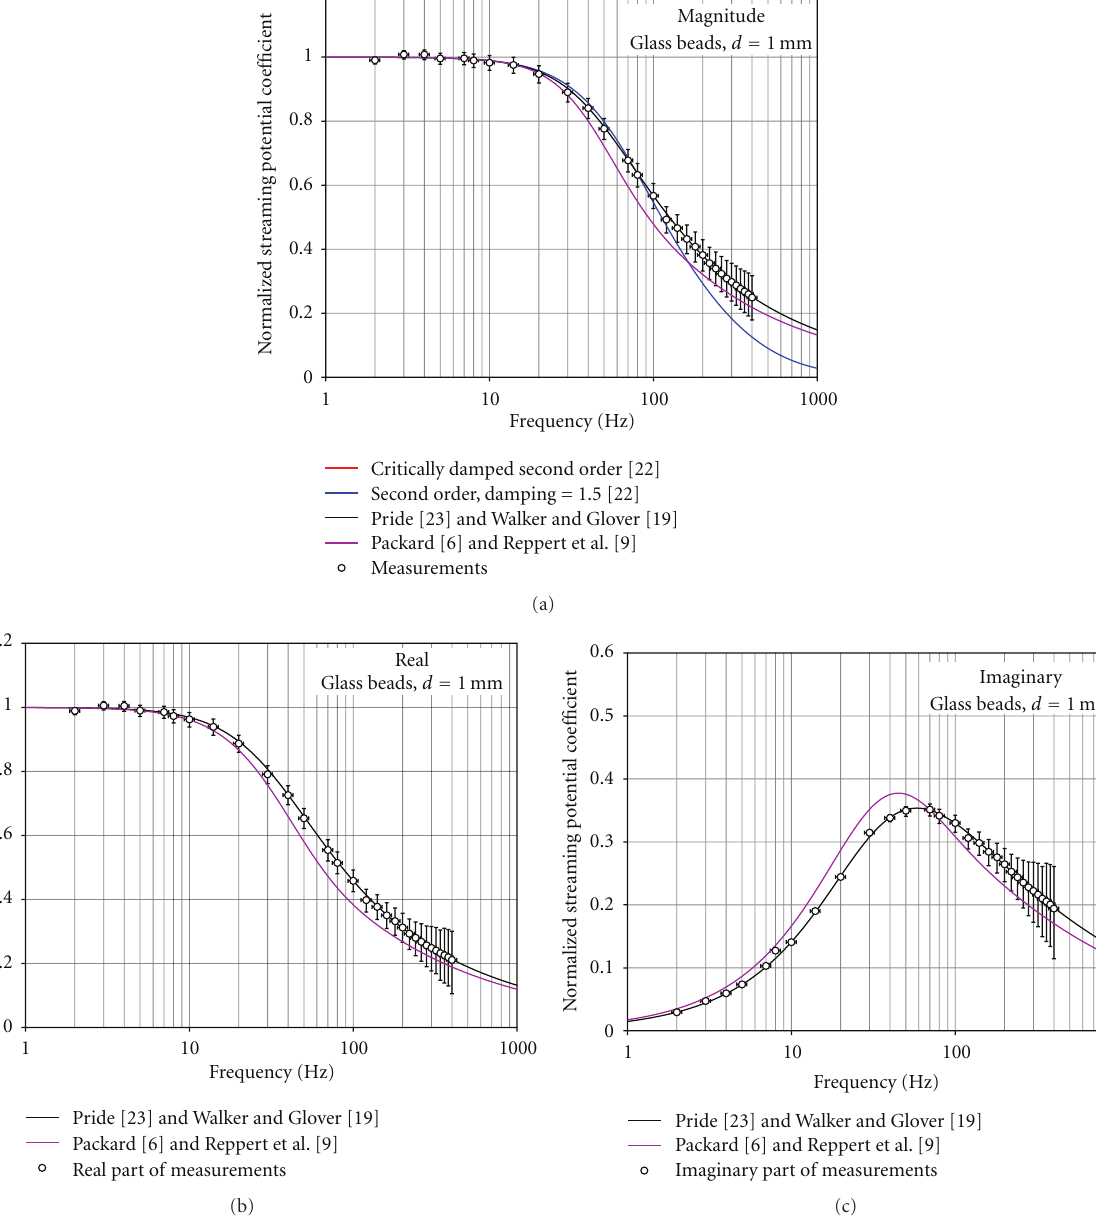
Figure 5: The calculated streaming potential coupling coe ffi cient (normalised to the value at 2 Hz, which was 1.61 V/MPa) as a function of frequency for a pack of nominally 1mm diameter glass beads saturated with 10 − 3 mol/L NaCl solution at 24 ◦ C ( φ = 0 . 38, κ DC = 5 . 95 × 10 − 10 m 2 ). (a) Magnitude with six models shown fitting the data [6, 9, 19, 22, 23], (b) real component for models [6, 9, 19, 23], and (c) imaginary component for models [6, 9, 19,